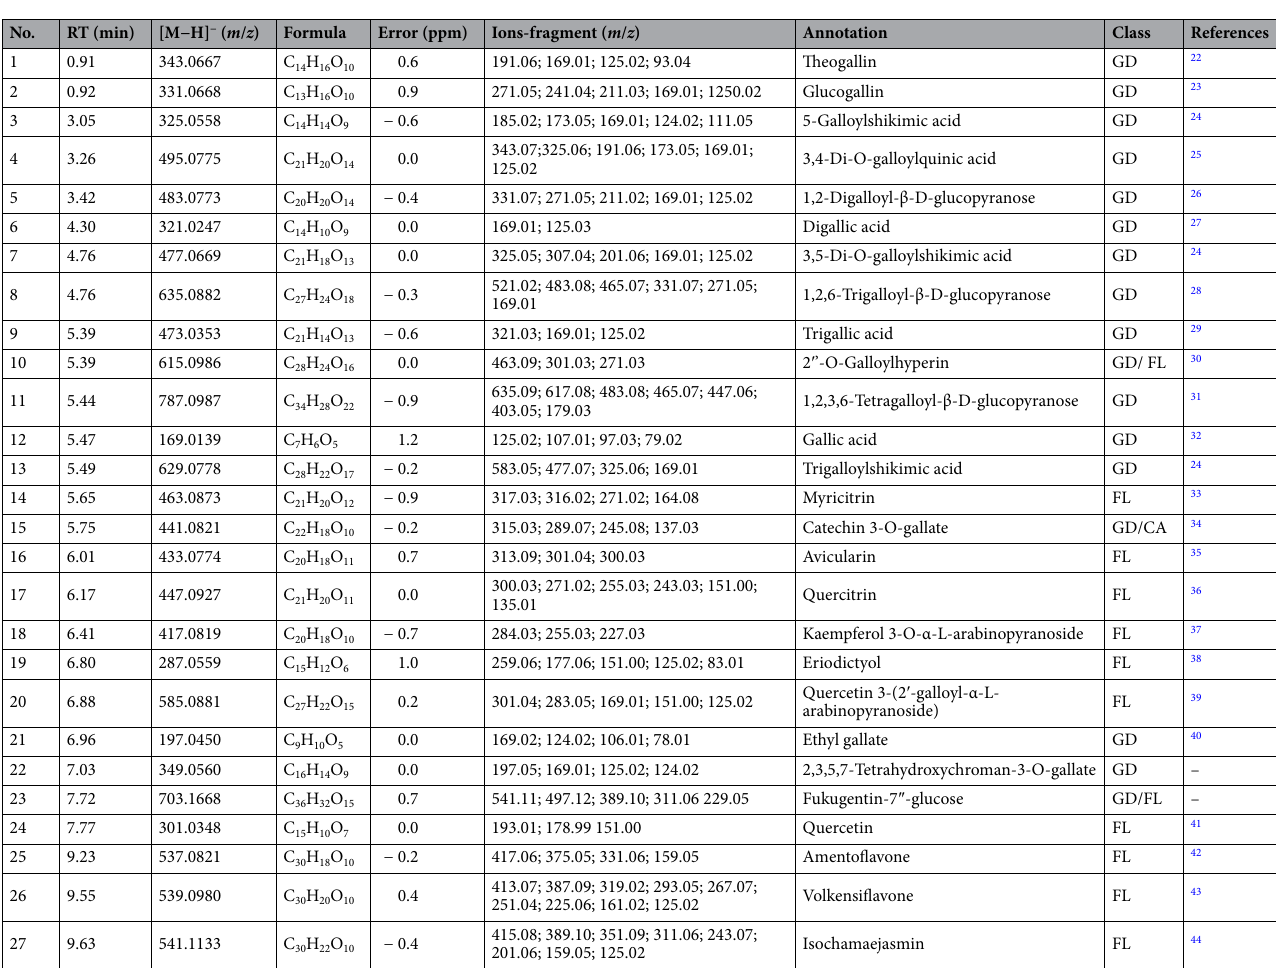
Table 2. Detected compounds from ethanolic extract of Schinus terebinthifolius (Brazilian pepper) by UPLC– QTOF–MS/MS. CA catechin, FL flavonoid, GD gallic acid